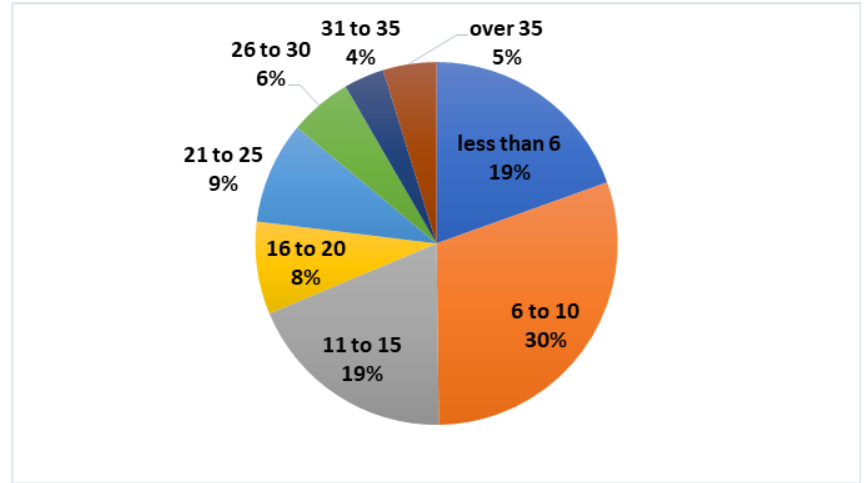
Figure A5. BW quantities discharged per single ship by ship type.